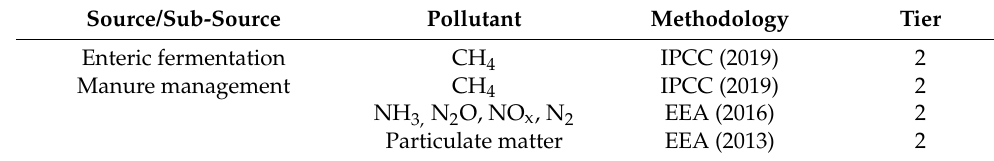
Table A1. Description of the methodology for GHG emission evaluation for each source and